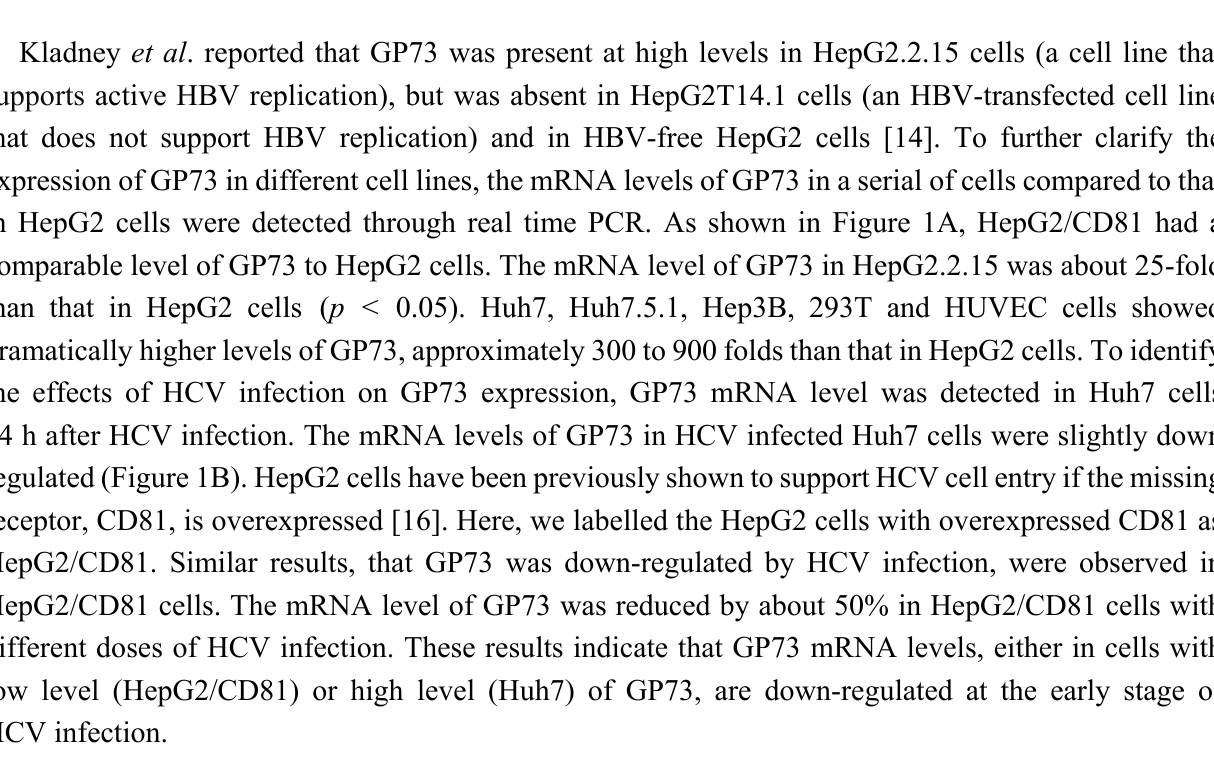
Figure 1. Effect of Hepatitis C virus (HCV) on Golgi protein 73 (GP73) expression